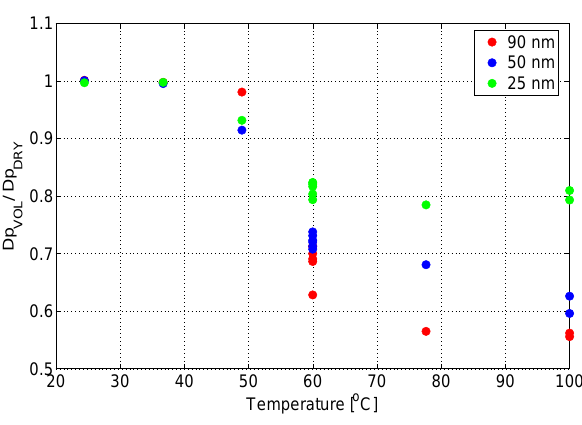
Fig. 10. Diameter of volatilised, initially 90, 50 and 25nm sized non-volatilised, dry particles as a function of volatilisation temper- ature presented in red, blue and green dots, respectively, measured on 29 January,